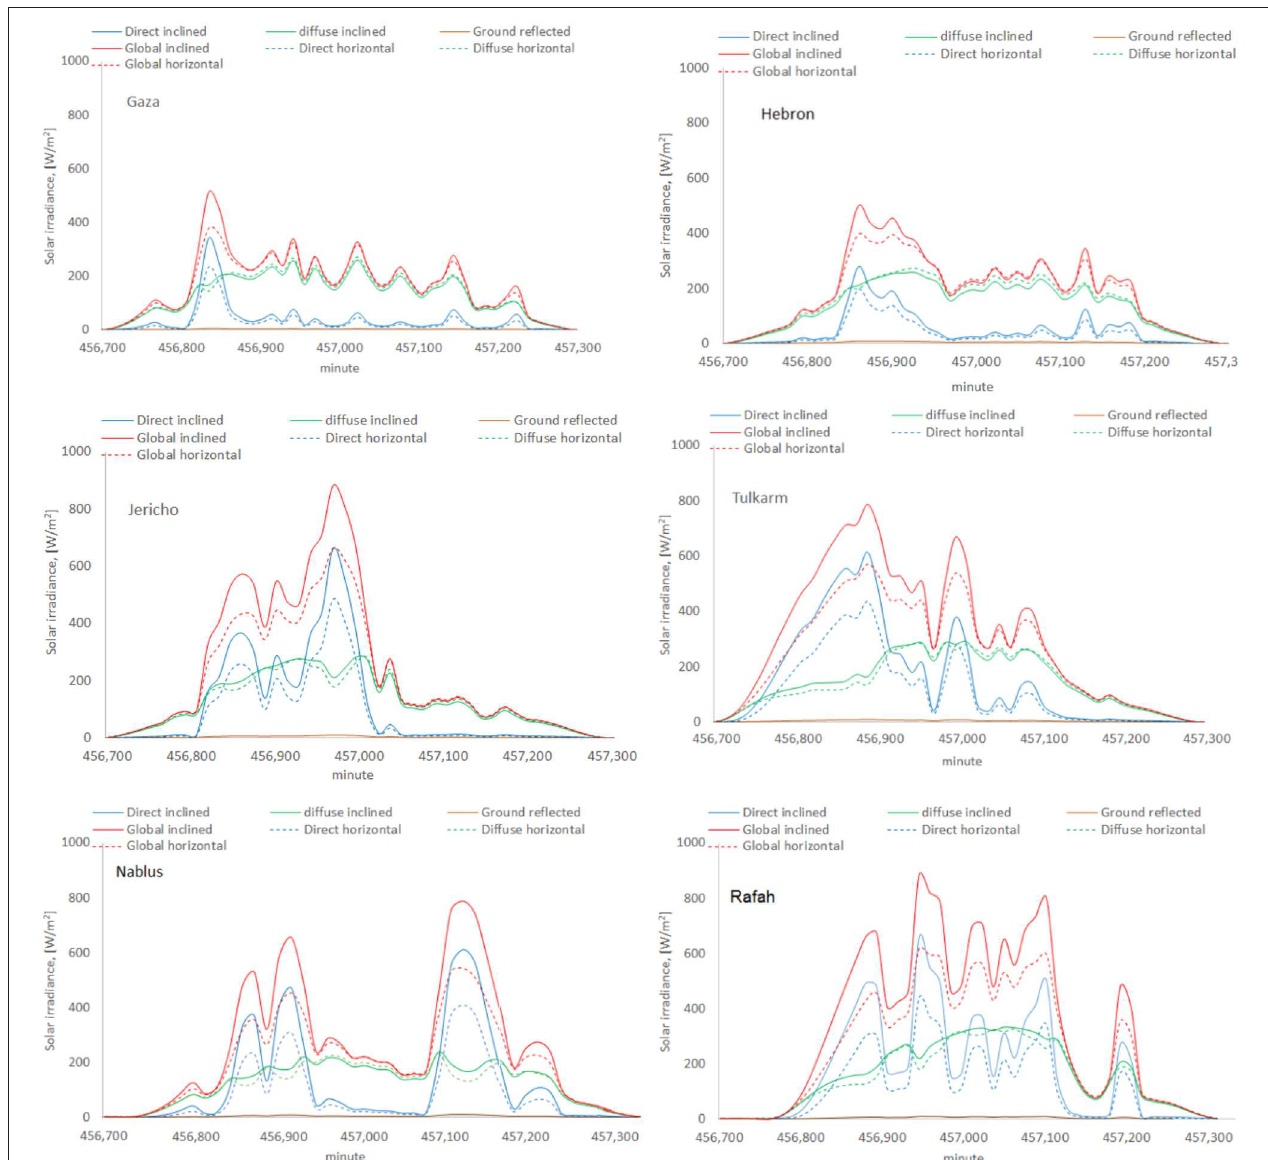
FIGURE 2 | Fifteen-minute time-series measurements and estimated solar radiation components for Gaza, Hebron, Jericho, Tulkarm, Nablus, and Rafah on November 21st,